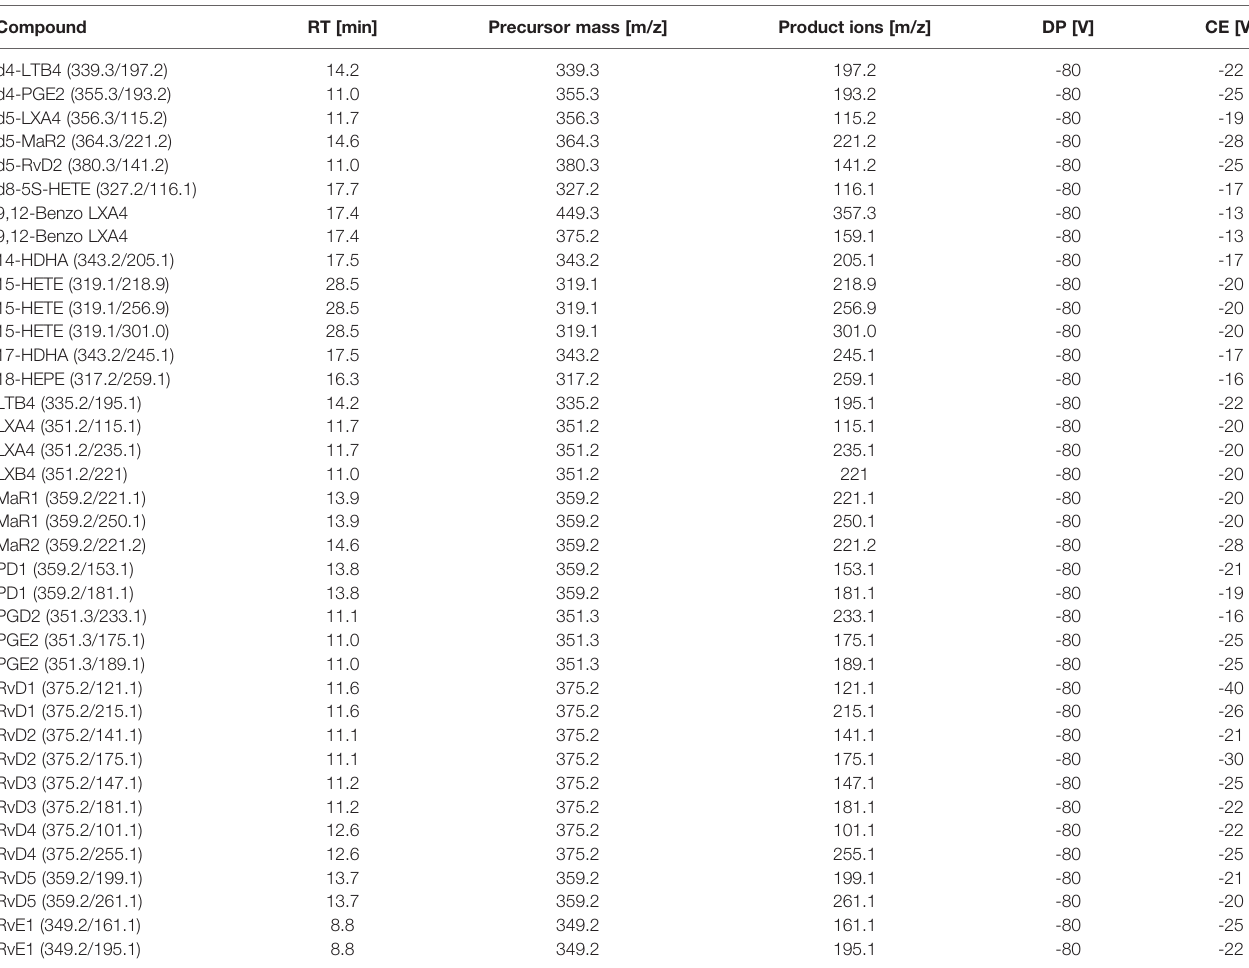
TABLE 1 | MRM-transitions for the detection of SPMs. Compound RT [min] d4-LTB4